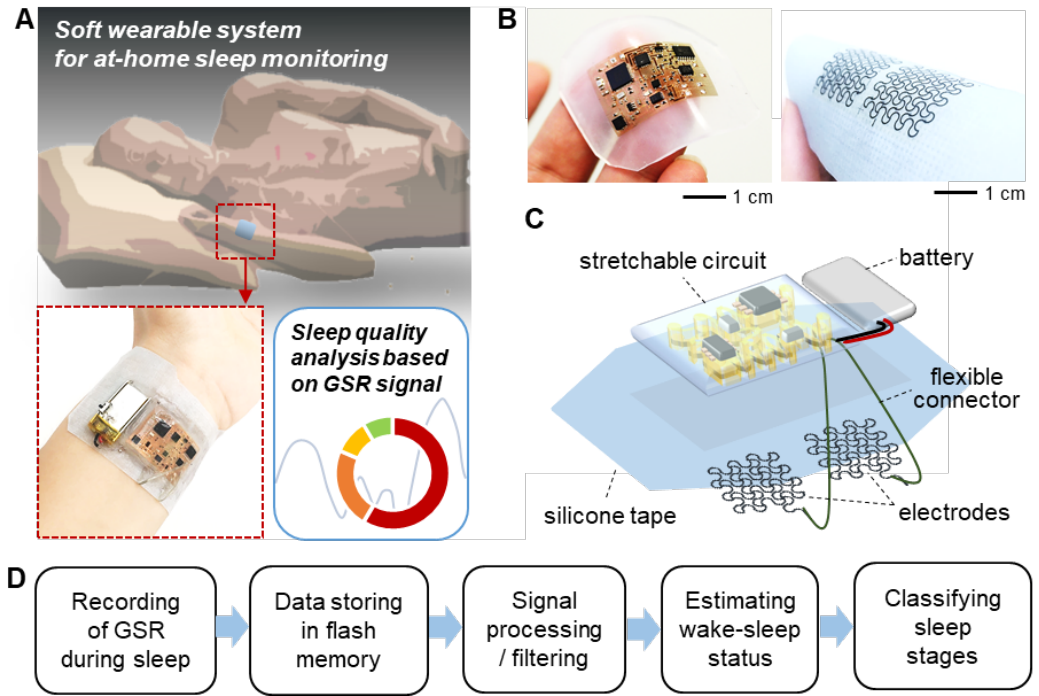
Figure 1. Overview of a soft wearable bioelectronic system for recording of electrodermal activity and home sleep monitoring. ( A ) Schematic illustration of a wearable patch on the wrist to assess sleep quality at home. ( B ) Photos showing a soft electronic system enclosed with an elastomer (left) and a pair of graphene electrodes on a silicone tape (right). ( C ) Illustration of the integrated bioelectronics, including a pair of electrodes, circuit, battery, and connector on a reusable silicone tape. ( D ) Flow chart that captures data recording and processing to quantify sleep stages at home.